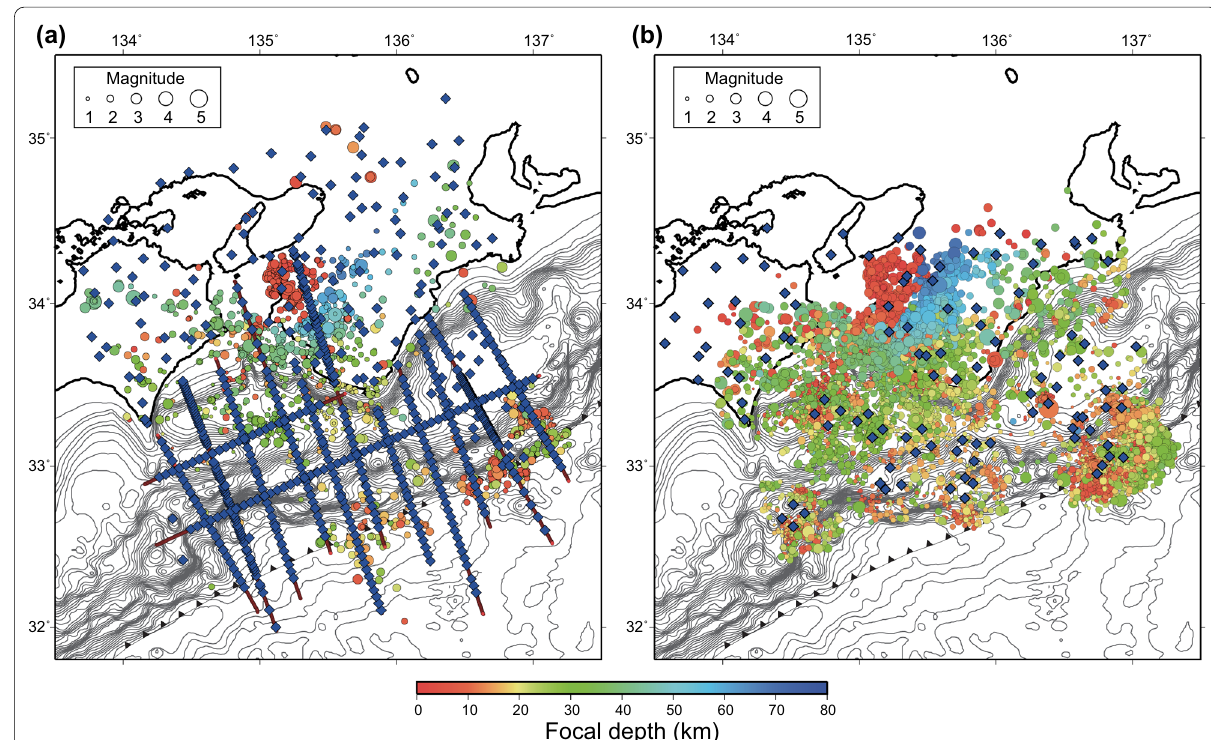
Fig. 2 Distribution of seismic stations and initial hypocenters. Blue diamonds and colored circle reflect the seismic stations and epicenters, respectively. a Selected dataset from Yamamoto et al. (2017). b Additional data in this